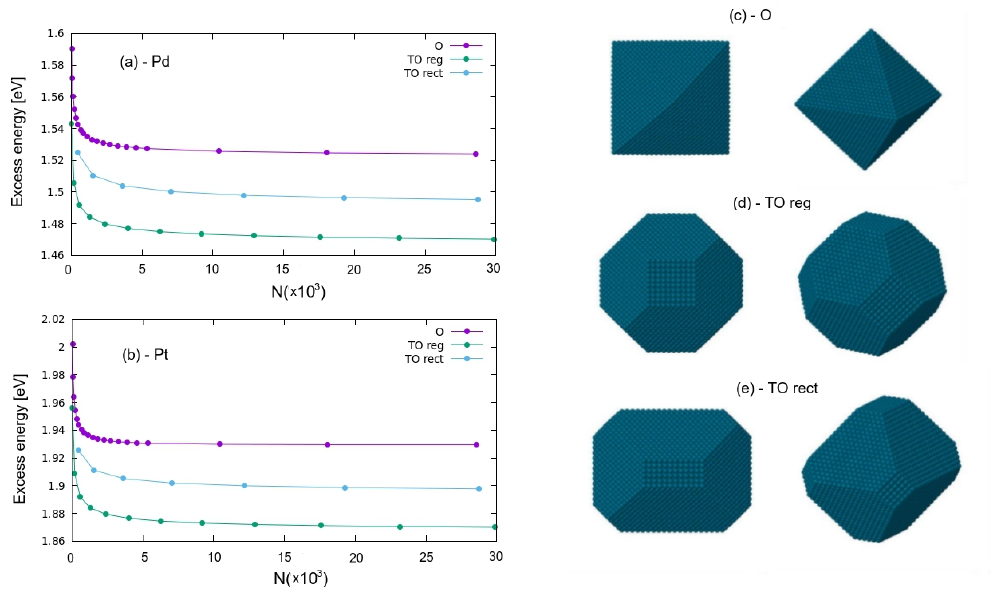
Figure 7. Excess energies (see Equation (1)) of pure ( a ) Pd and ( b ) Pt nanocrystals of different shapes (( c )—regular octahedron, ( d )—regular truncated octahedron and ( e )—truncated octahedron with rectangular base), where ε coh is equal to 3.91127 eV for Pd and 5.82801 eV for